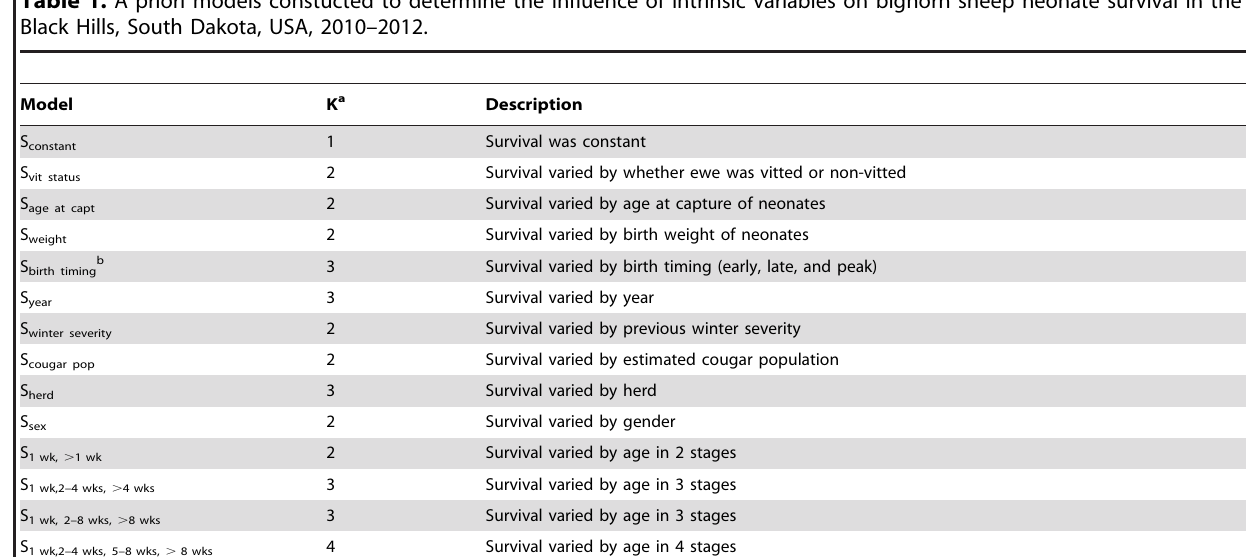
Table 1. A priori models constucted to determine the influence of intrinsic variables on bighorn sheep neonate survival in the Black Hills, South Dakota, USA, 2010–2012.